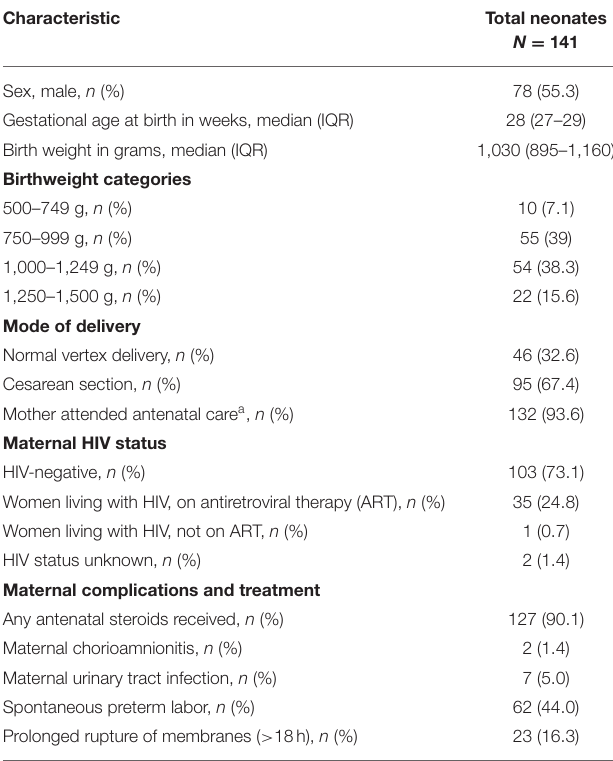
TABLE 1 | Characteristics of mothers and very low birth weight neonates receiving antimicrobials for blood stream infection episodes ( n = 141).